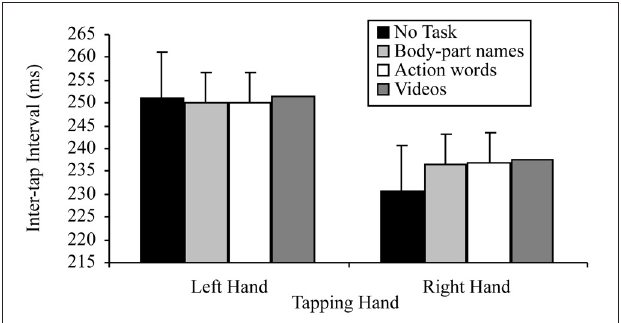
FIGURE 9 | Mean inter-tap intervals of each hand under the different concurrent task conditions (error bars represent one standard error of the